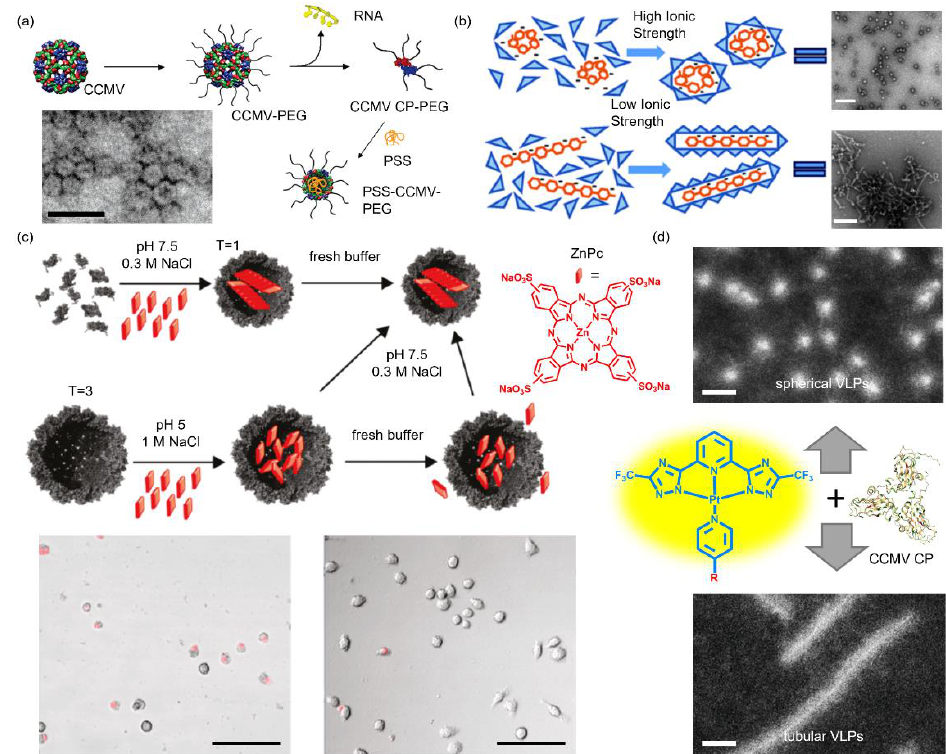
Figure 4. CCMV VLPs assembled around synthetic polymers and amphiphiles. ( a ) Schematic pathway of CCMV-PEG assembly templated by PSS and the characterization result from TEM measurement. Scale bar: 50 nm. Reprinted with permission from [54]. Copyright (2009) American Chemical Society. ( b ) Schematic presentation of the morphological manipulation of CCMV VLPs through the template structure transition that is controlled by NaCl concentration and the corresponding TEM images. Scale bar: 200 nm. Reprinted with permission from [60]. Copyright (2011) American Chemical Society. ( c ) Schematic illustration of the encapsulation of ZnPc dyes into CCMV VLPs and the cell images (bottom left panel) in the presence and (bottom right panel) in the absence of ZnPc-loaded capsids. Both images are the overlap of fluorescence images and transmission images of RAW 264.7 macrophage cells. Scale bar: 100 μm. Reprinted with permission from [62]. Copyright (2011) American Chemical Society. ( d ) Spherical and tubular CCMV VLPs templated by tailor-made Pt(II) amphiphiles. Scale bar: 50 nm. Reprinted with permission from [63]. Copyright (2018) American Chemical Society.